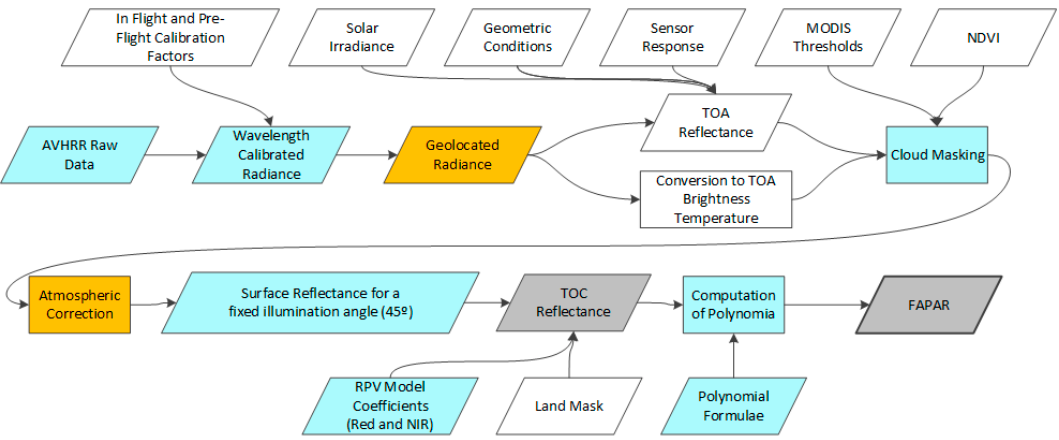
Figure 8 . QA4ECV AVHRR FAPAR product top-level traceability chain. NDVI; normalised difference vegetation index; and RPV model: Rahman–Pinty–Verstraete model.